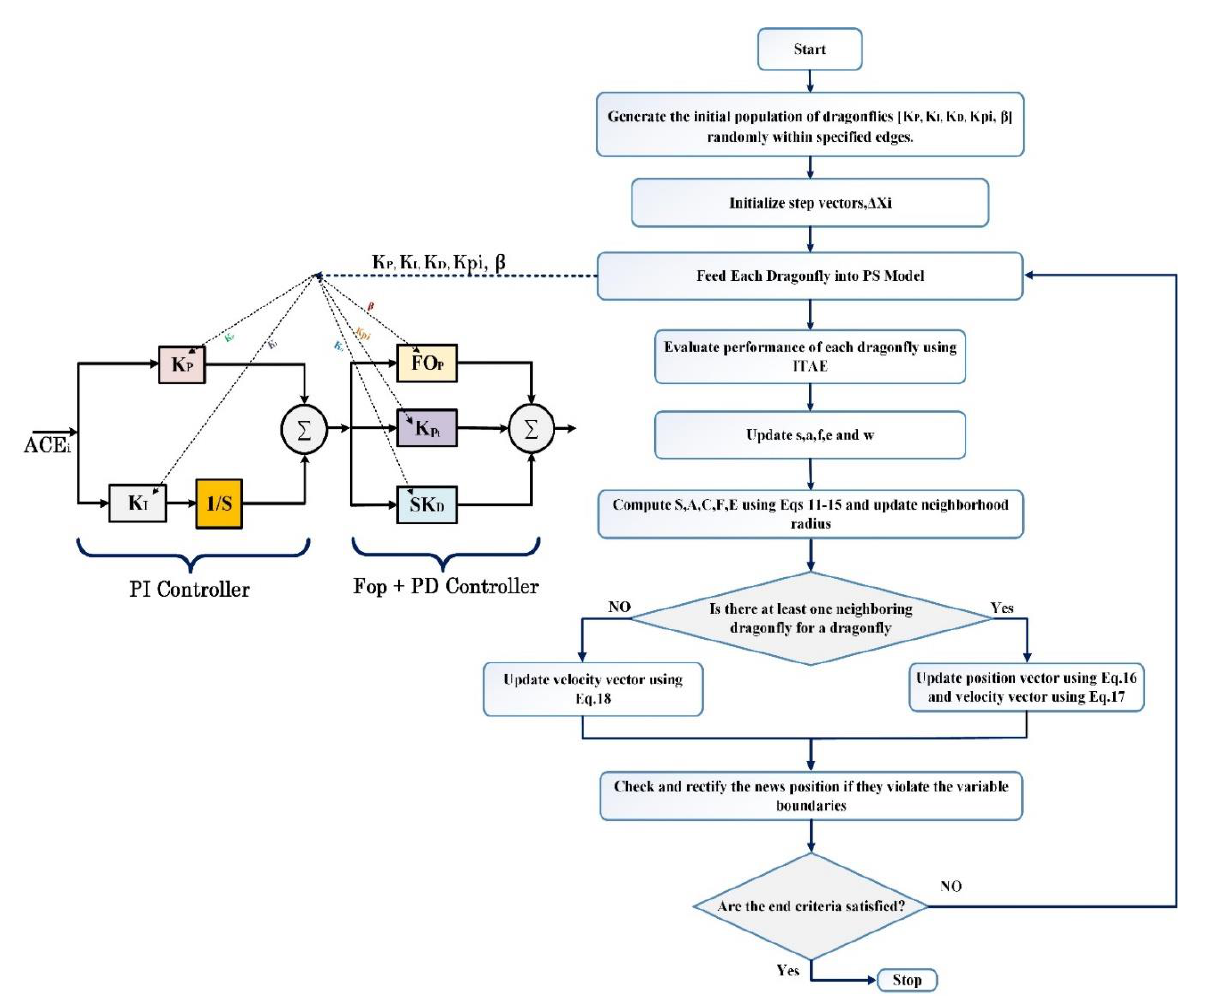
Table 1. DSA initializing parameters.